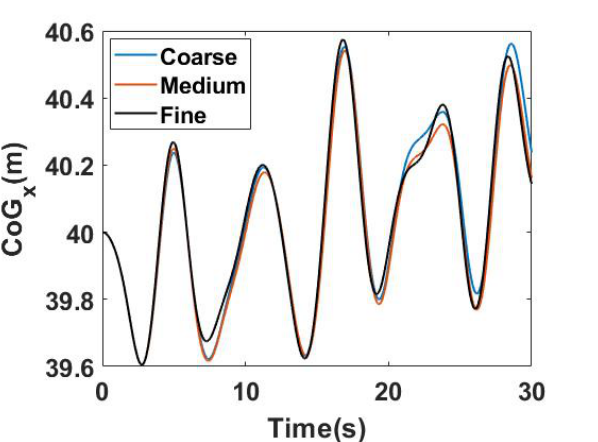
Figure 6. x-directional motion of the center of gravity of the device with different mesh